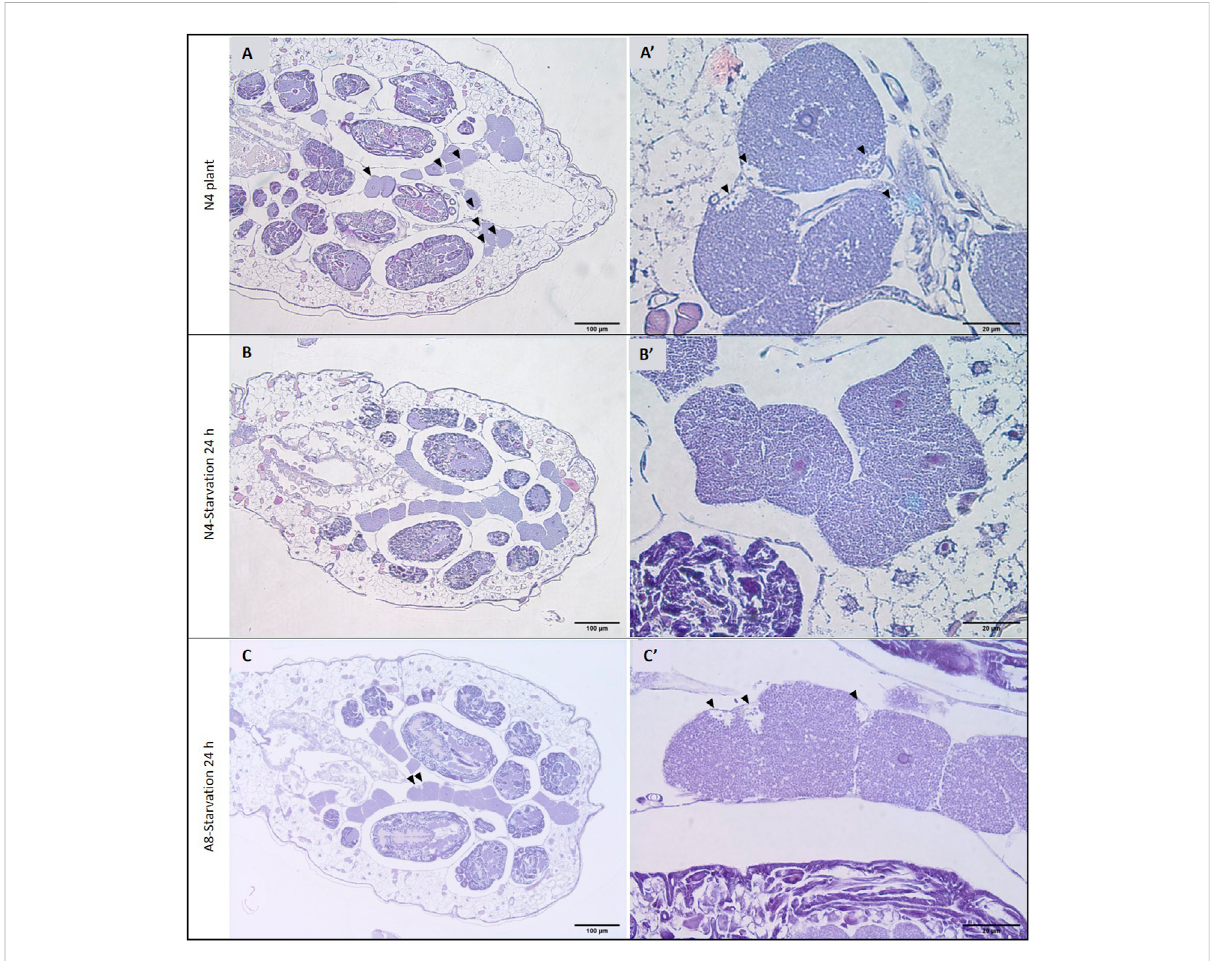
Effect of starvation on bacteriocyte phenotype. H&E staining of seven-day-old (N4 stage) aphids reared on plant from birth (A) or that were transferred back to plant after a 24 h starvation period (B) . H&E staining of eight-day-old (adult) aphids from the starved population (C) . (A 9 – C 9 ) Higher magni fi cation of representative bacteriocytes displaying low symbiont density zones. Arrowheads indicate low symbiont density zones that are characteristic of aphid bacteriocyte cell